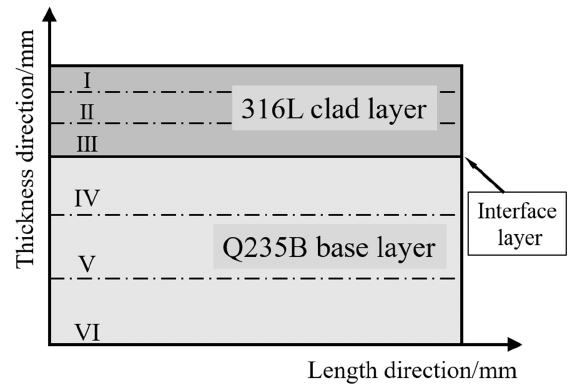
Figure 15. Layering diagram of 316L/Q235B composite plate.